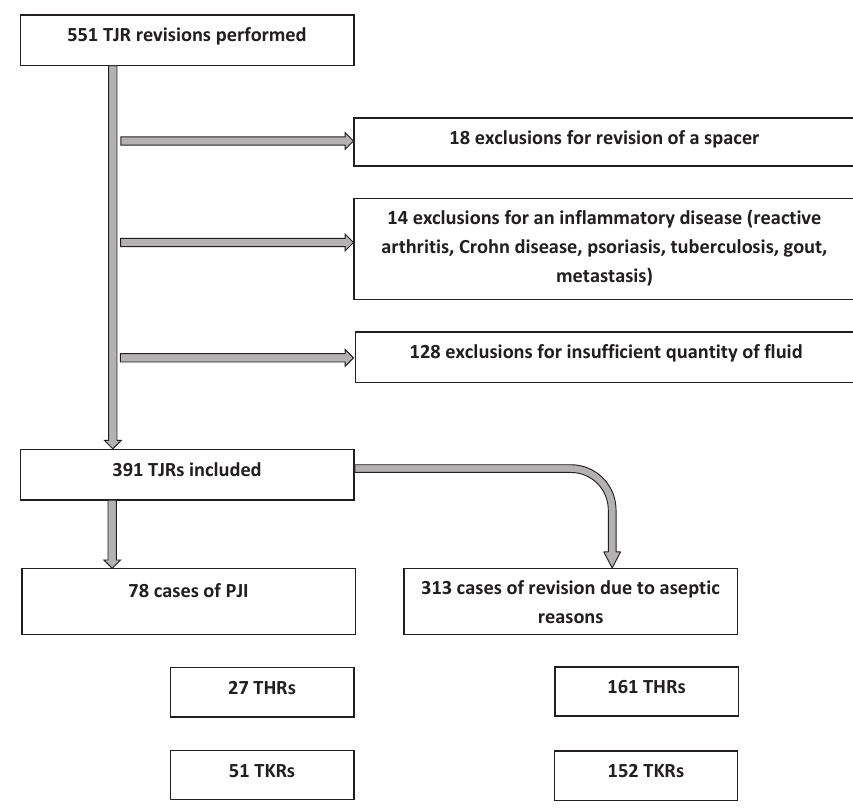
Fig. 1. Flowchart showing the number of included and excluded patients as well as their distribution in the infected and non-infected